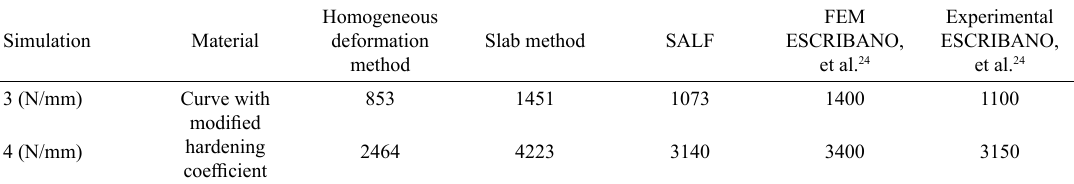
Table 3. Force versus reduction - simulation 3: reduction of 5%; simulation 4: reduction of 30%. Simulation